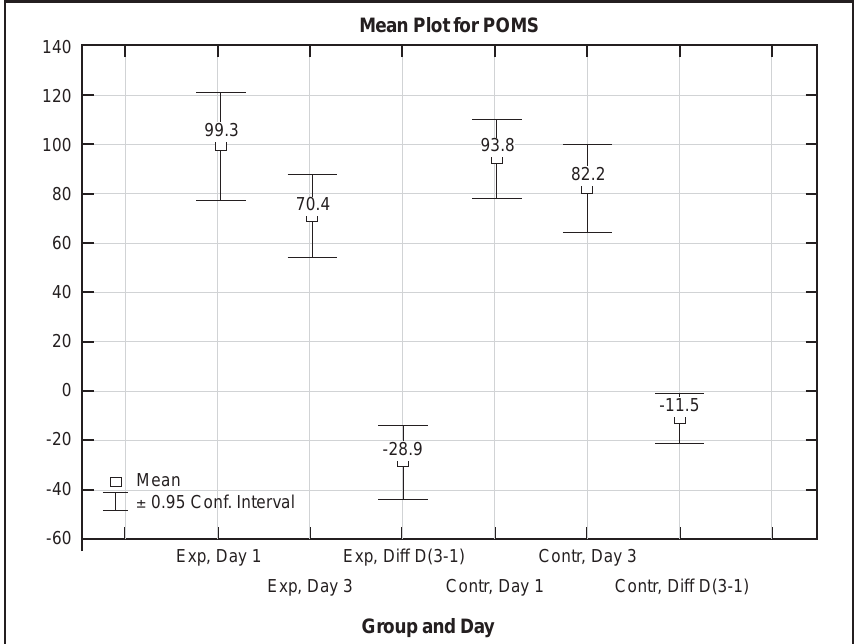
Figure 1: The parameters of the POMS subscale comparing the experimental and control